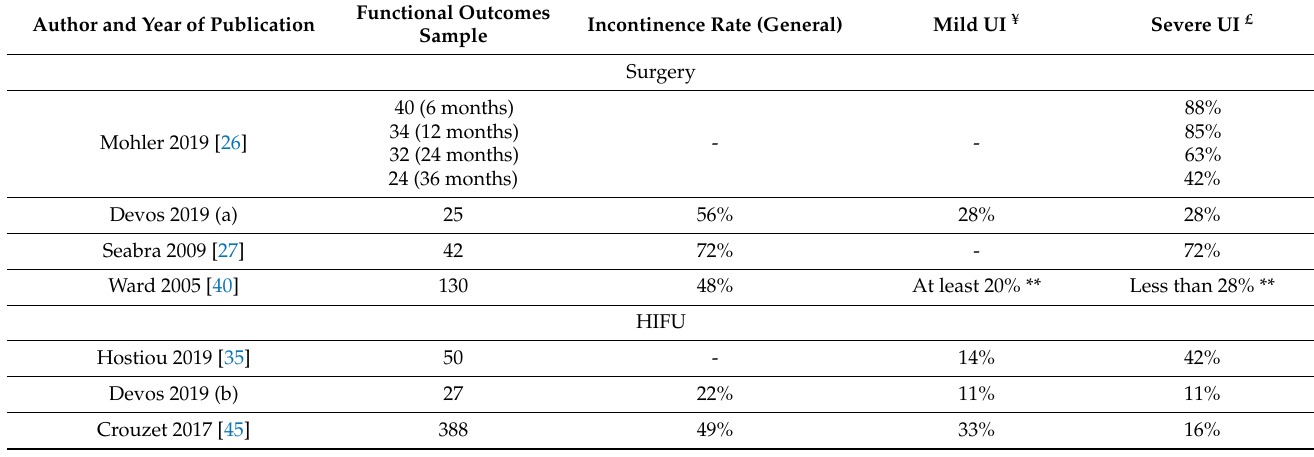
Table 2. Urinary function outcomes after various salvage interventions presented as mild versus severe urinary incontinence. Author and Year of